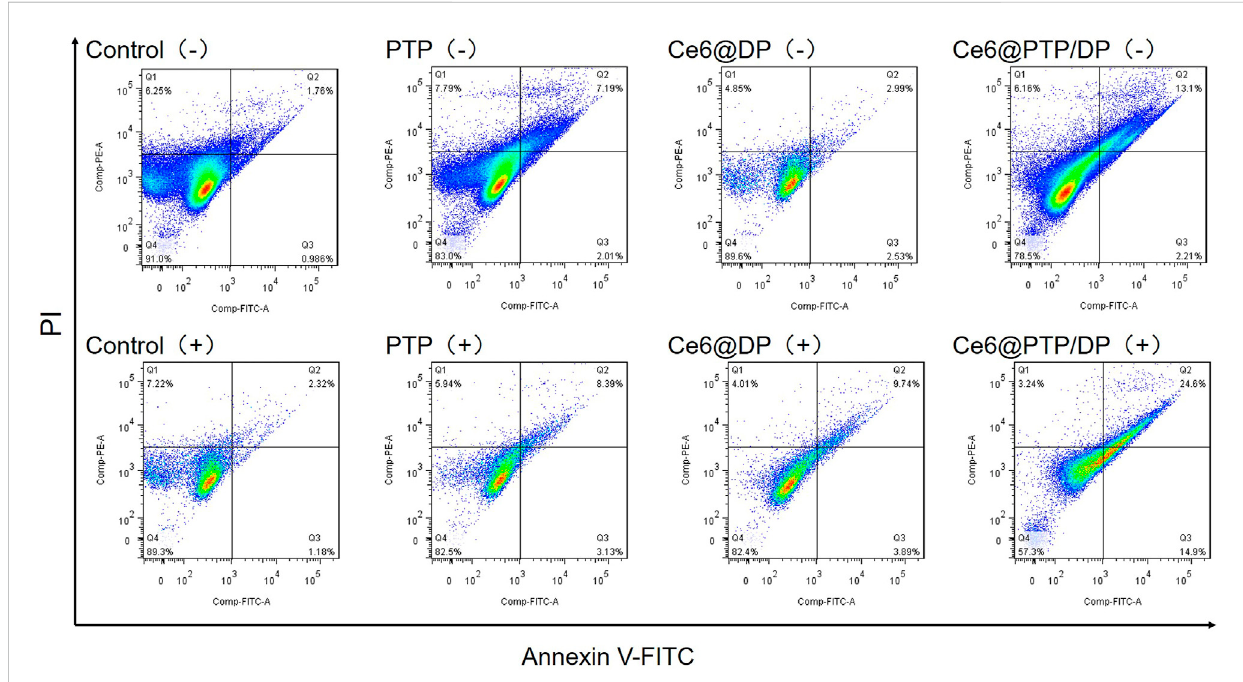
FIGURE 9 Apoptosis of HeLa cells induced by PTP, Ce6@DP, Ce6@PTP/DP for 48 h ( − ) (without light irradiation), and (+) (white light, 100 mW cm − 2 , 10